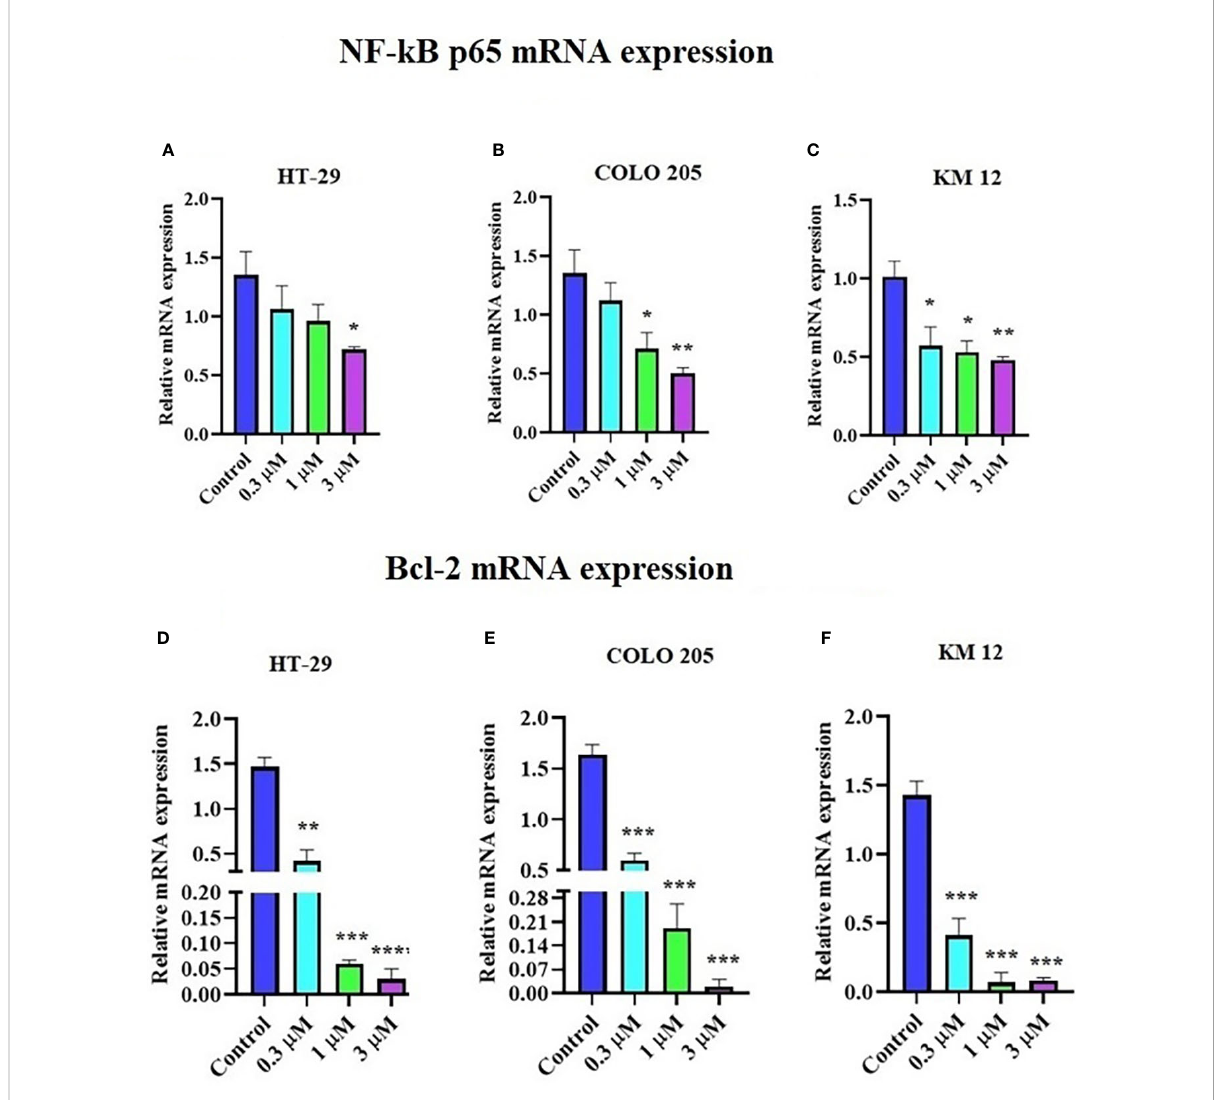
FIGURE 5 Effect of ITH-6 on NF- k B p65 and Bcl-2 expression at mRNA levels on HT-29, COLO 205, and KM 12 cells. The effect of ITH-6 on NF- k B p65 mRNA expression on (A) HT-29, (B) COLO 205, (C) KM 12 cells, and Bcl-2 mRNA expression on (D) HT-29, (E) COLO 205, and (F) KM 12 cells was tested after the cells were treated with 0.3, 1, and 3 µM of ITH-6 different concentrations for 72 hours. Points with error bars represent the mean ± SD for independent determinations in triplicate. The fi gures are representative of three independent experiments. * p <.05, ** p <.01, *** p <.001 and **** p <.0001 compared with the control